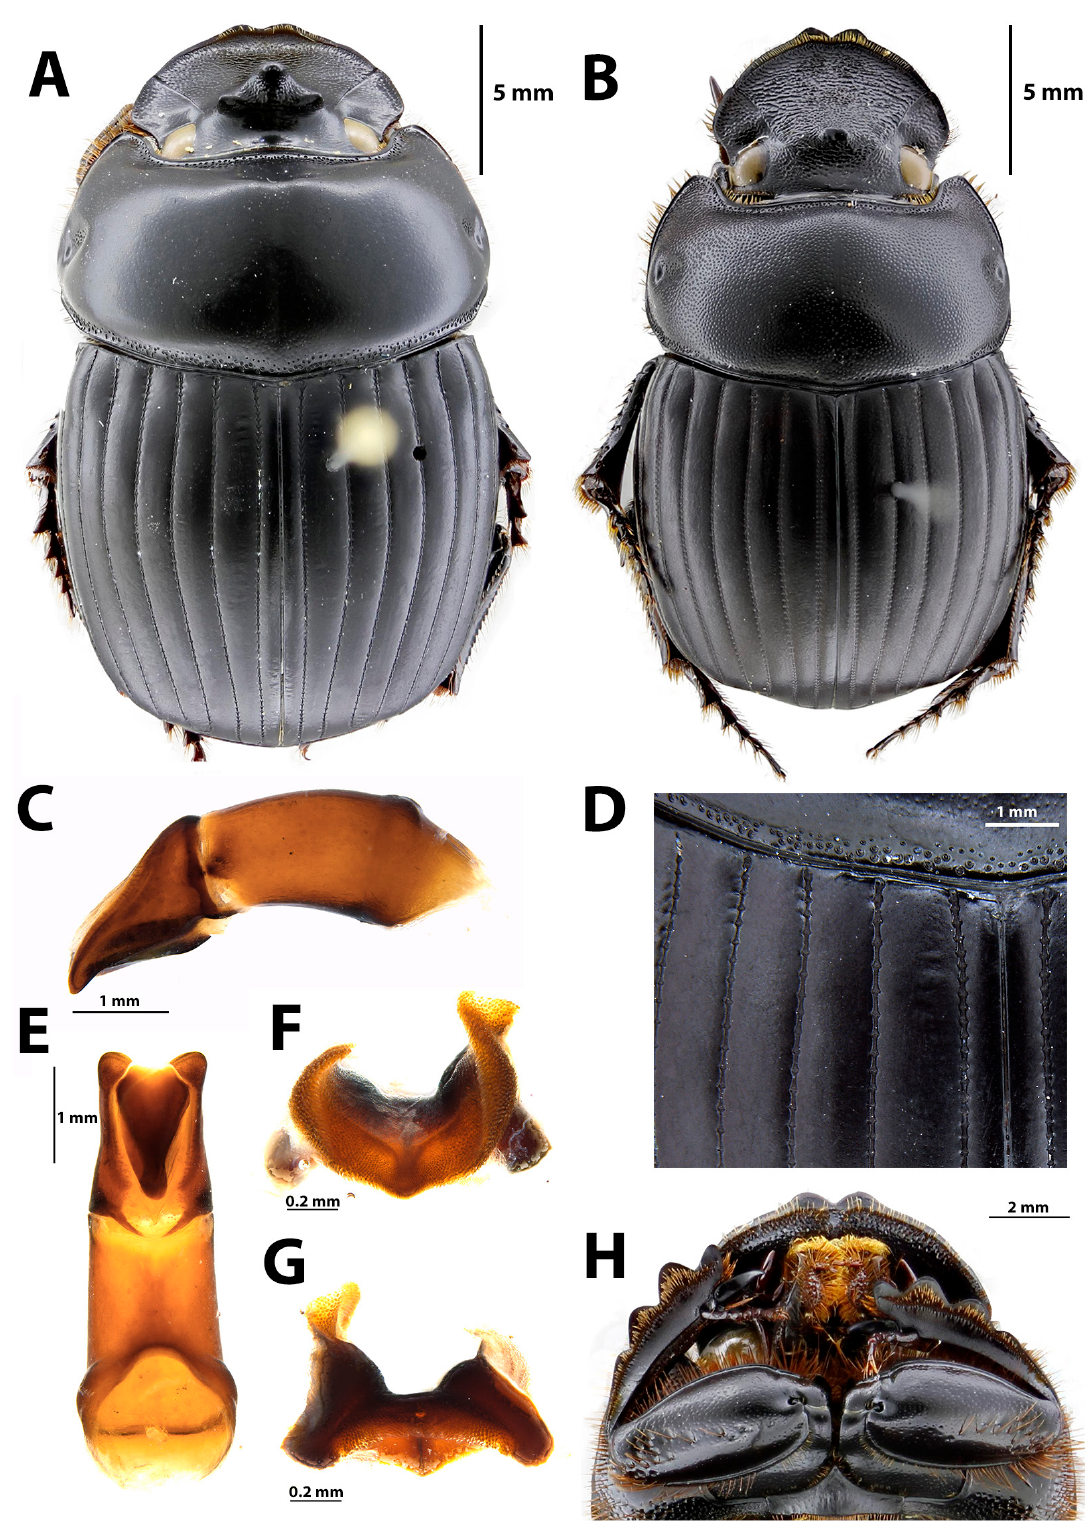
Fig. 8. Dichotomius enioi sp. nov. A–B . Dorsal habitus. A . Holotype, ♂ (CEMT). B . ♀. C . Lateral view of the aedeagus. D . Ocellate punctation of the posterior margin of the pronotum; elytral interstriae shagreened. E . Ventral view of the aedeagus. F–G . Lamella copulatrix. H . Profemur covered with well- impressed punctures, setigerous setae near the medial